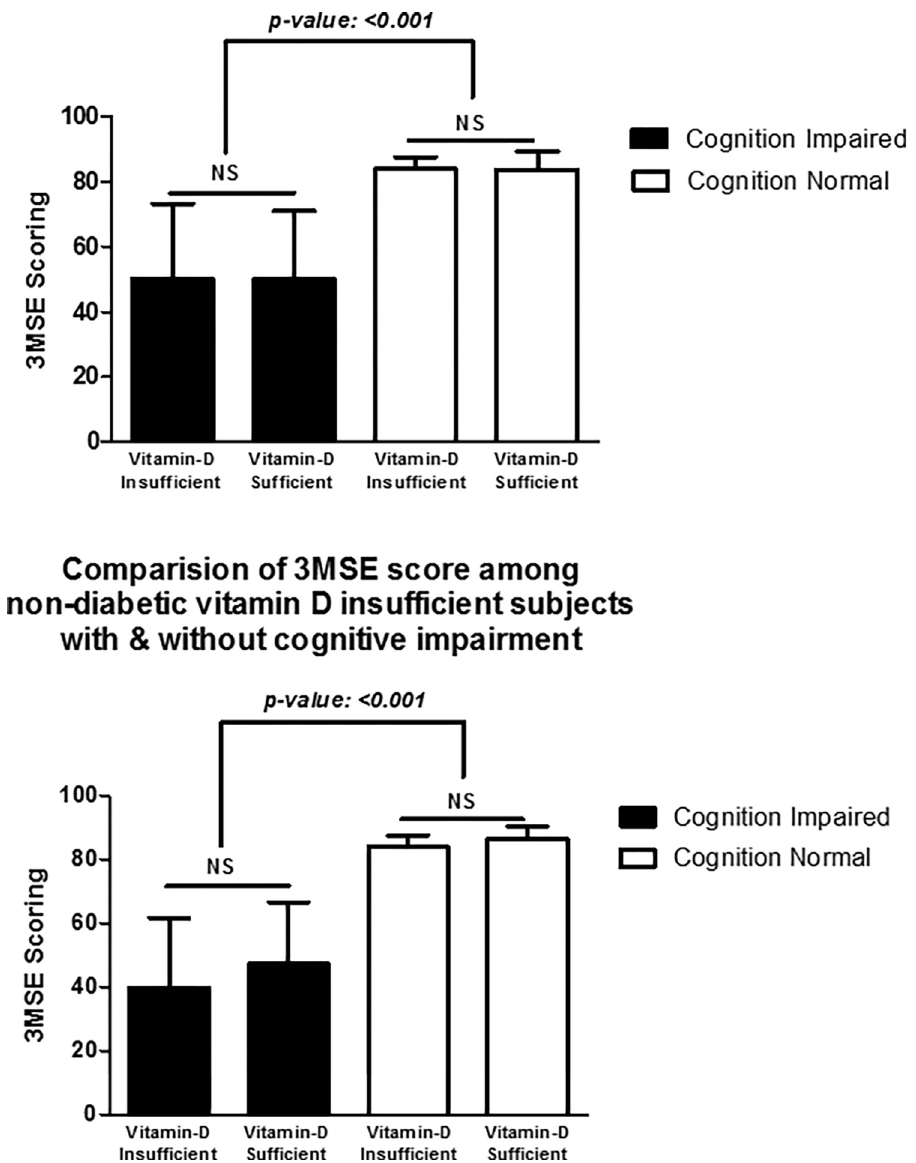
Fig 3. Comparison of 3MSE scoring in diabetic and non-diabetic subjects among vitamin-D insufficiency and sufficiency group.